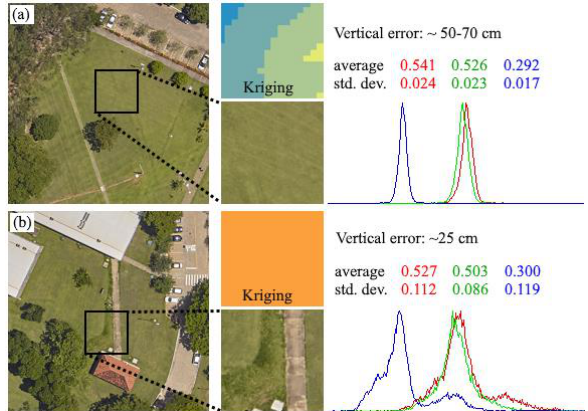
Figure 3 – Influence of texture information on DIM vertical accuracy for 2 areas: homogeneous (a) and heterogeneous (b). The average and standard deviation are in DN (digital numbers), normalized in the interval [0,1] for each image band (R, G,